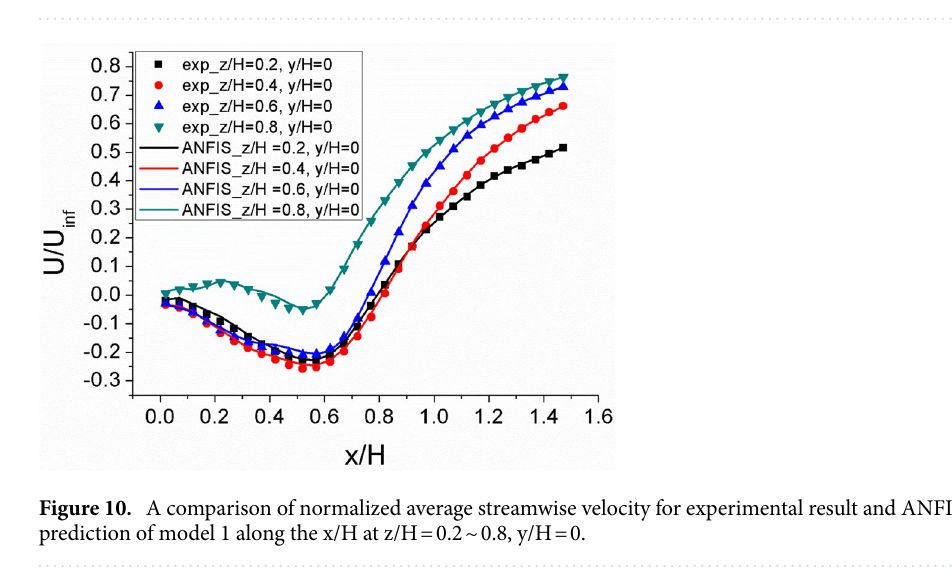
increase in the spatial resolution. Moreover, the four-times higher temporal resolution of the ANFIS model revealed much more small-scale streamwise vortical structures than those from only an enhancement of the spatial resolution. Compared to the average streamwise vortex structure, the instantaneous vorticity field was not a symmetrical feature. Clusters of the vortex structure rotating clockwise or counterclockwise were inclined to the bottom with downwash flow. During the measurement period of Fig. 11c–f, the vortex structures rotating clockwise were above the vortex structures rotating counterclockwise, but at other times it could be the opposite